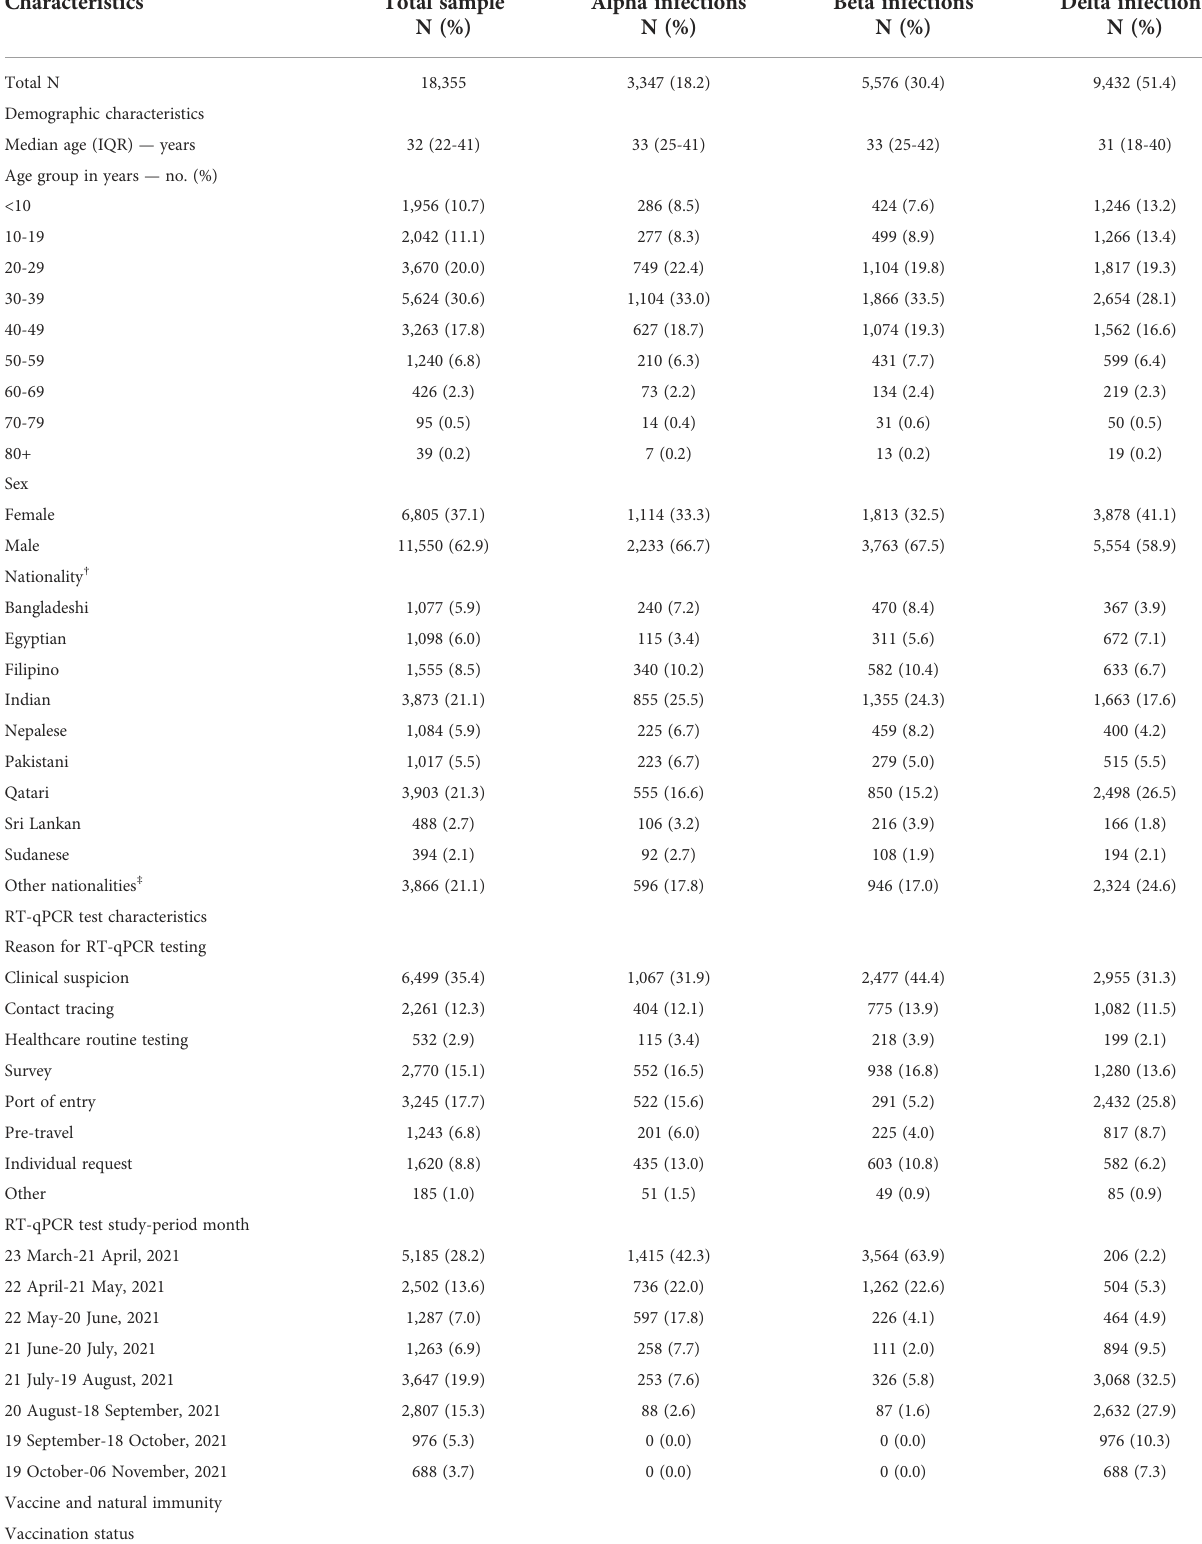
TABLE 1 Characteristics of the 18,355 RT-qPCR-genotyped SARS-CoV-2 infections between March 23 and November 6, 2021.